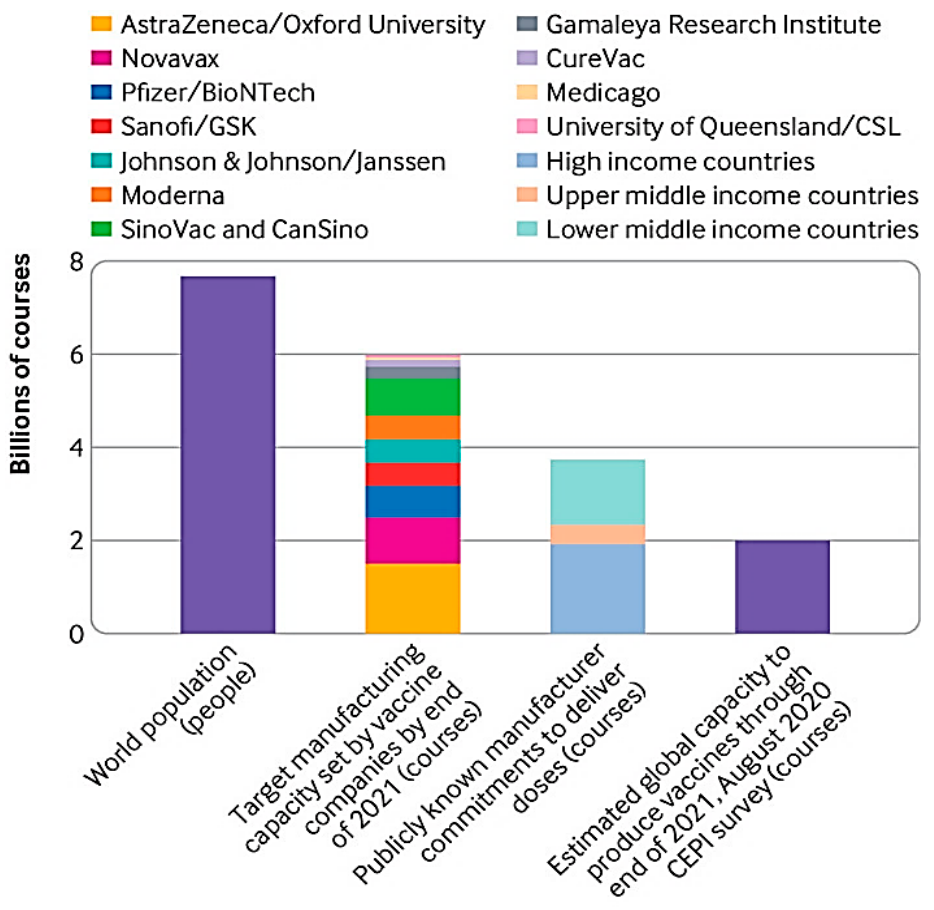
Figure 14. Manufacturing capacity by end of 2021 of lead companies producing COVID-19 vaccines. (Vaccine courses are assumed to require two doses) [399].